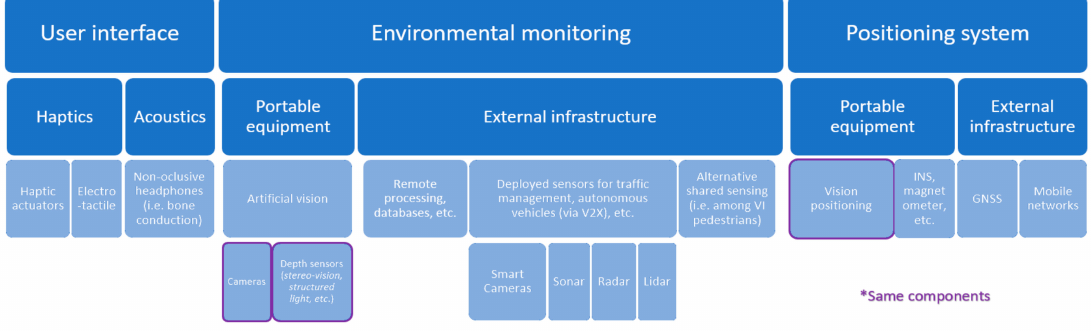
Figure 9. Architecture proposal for navigation assistance devices (examples